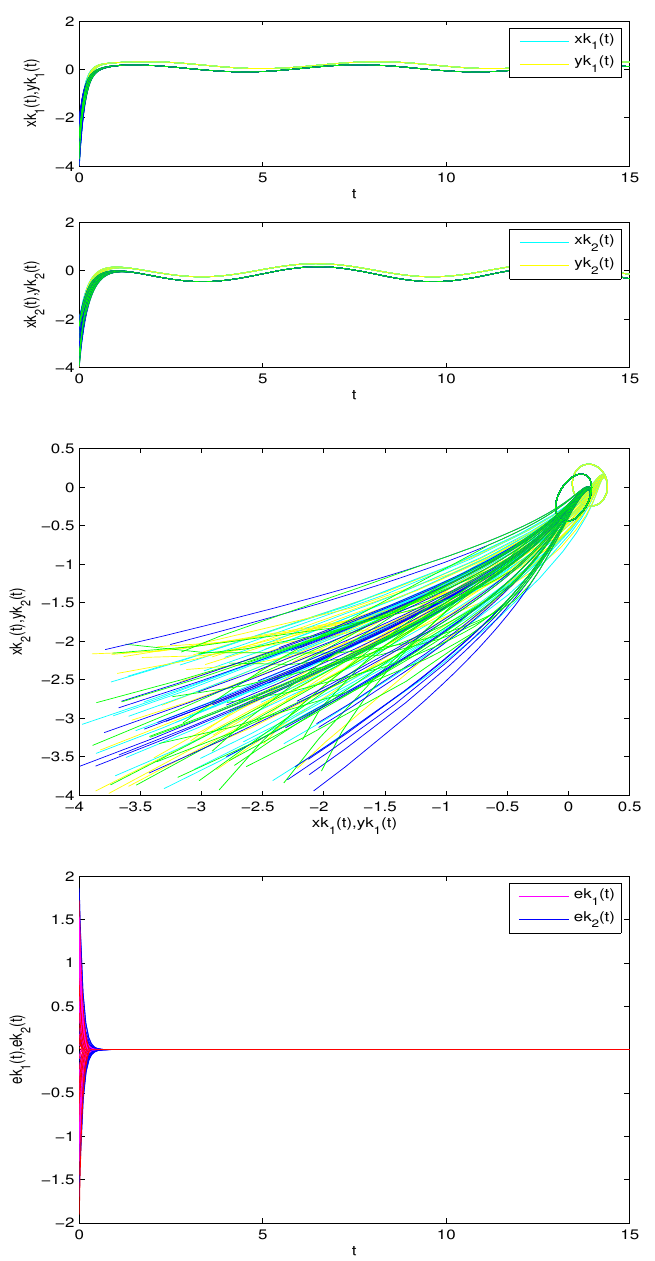
Figure 12. Instantaneous error states for the K part between for the variable ˘ x of (18) and ˘ y of (19) under 30 random initial values for two kinds of